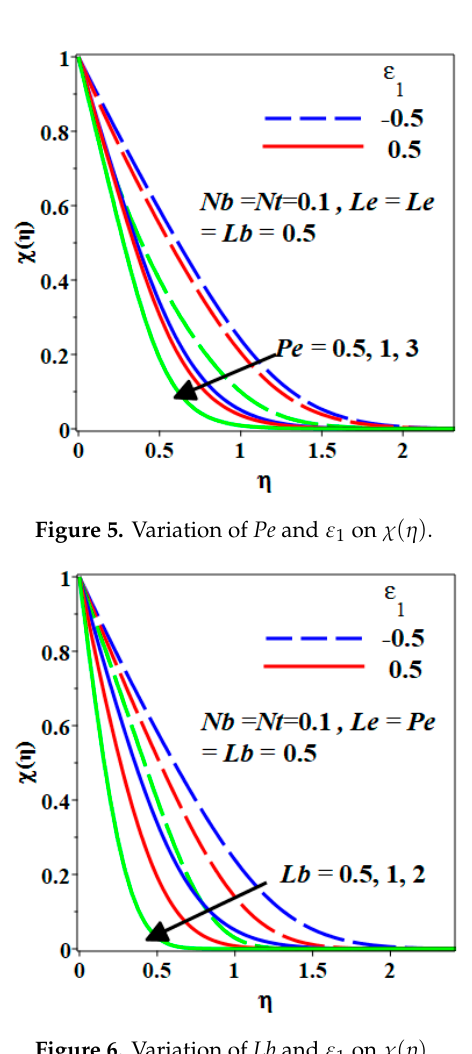
Figure 6. Variation of Lb and